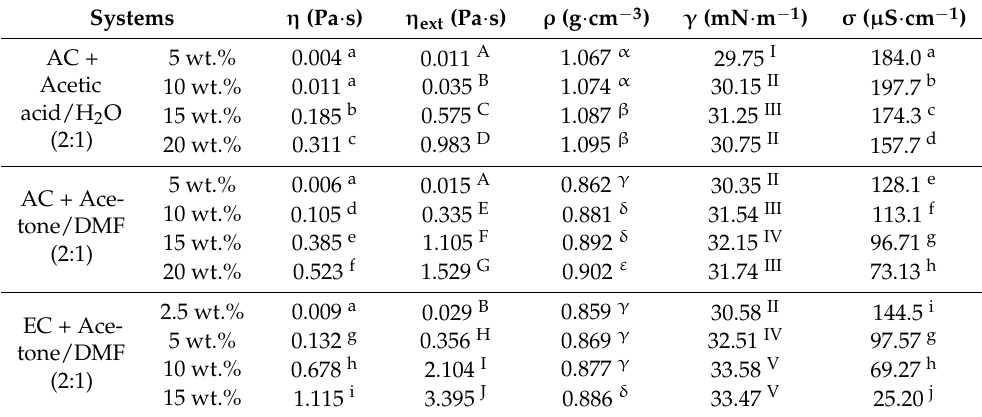
Table 1. Rotational viscosity ( η ), extensional viscosity ( η ext ), density ( ρ ), surface tension ( γ ), and conductivity ( σ ) values of the different AC and EC solutions. Different letters in each column present significant differences between the parameters ( p <